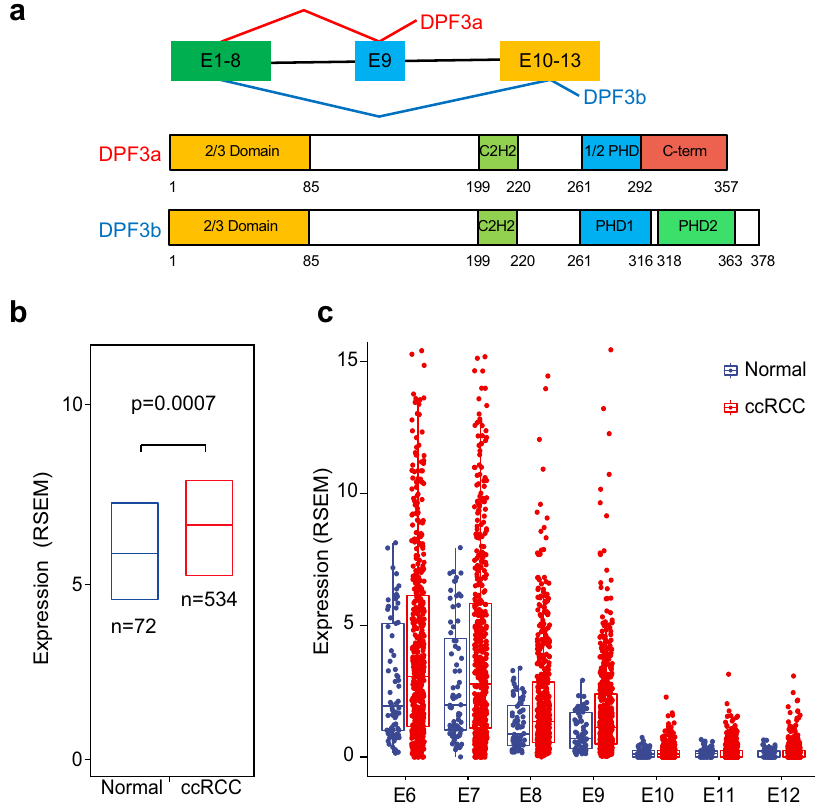
Fig.1|Upregulatedexpressionof DPF3 inccRCC.a Schematic representationof the DPF3 splicing isoforms and the corresponding protein structures. b Expression analysis of DPF3 in normal kidney tissues ( n =72 individuals) and ccRCC patients from the TCGA-KIRC cohort ( n =534 individuals). Results represent median expression levels with 25 and 75% quartile. Y-axis represents the expression values of expectation-maximization (RSEM). Statistical